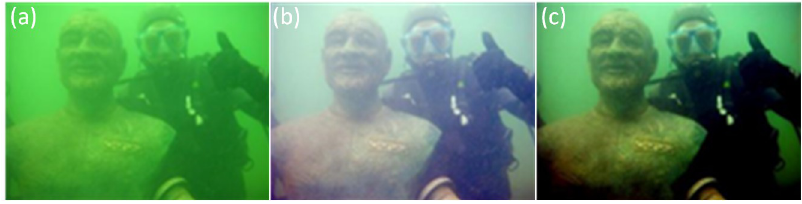
Fig 5. Different enhancement effects of the algorithms based on Retinex. (a) Original image; (b) MSR; (c) IMSRCP.